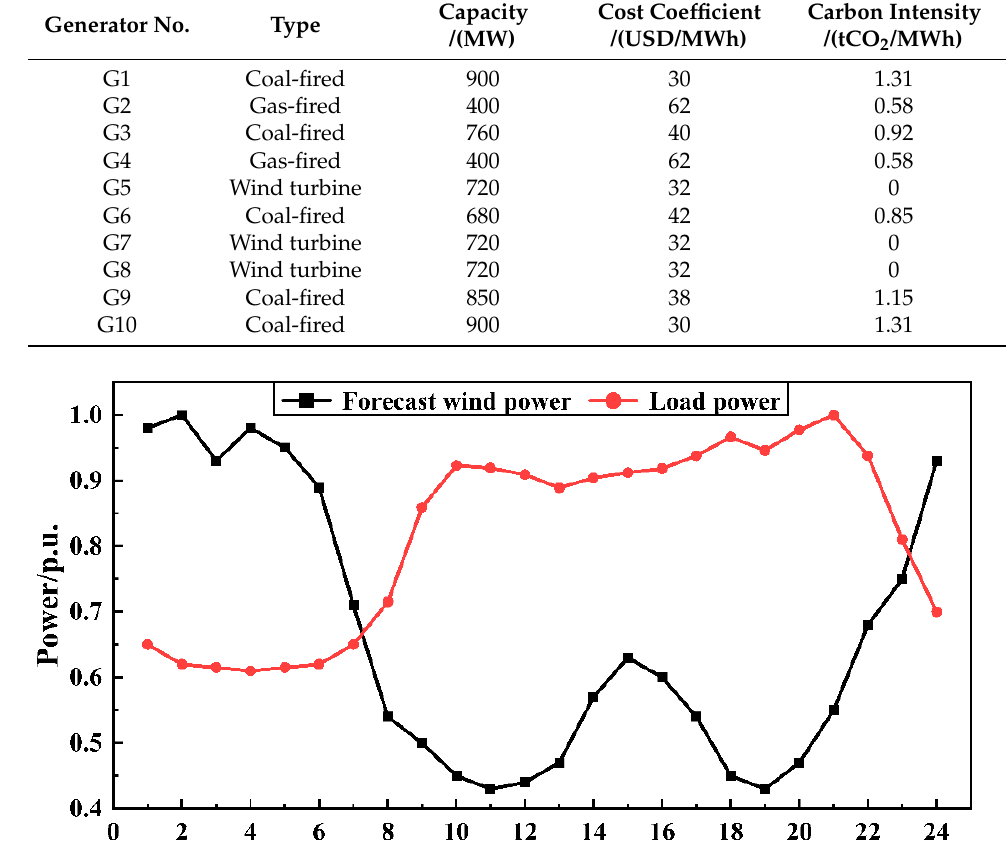
Figure 2. The modified New England 39-bus test system.